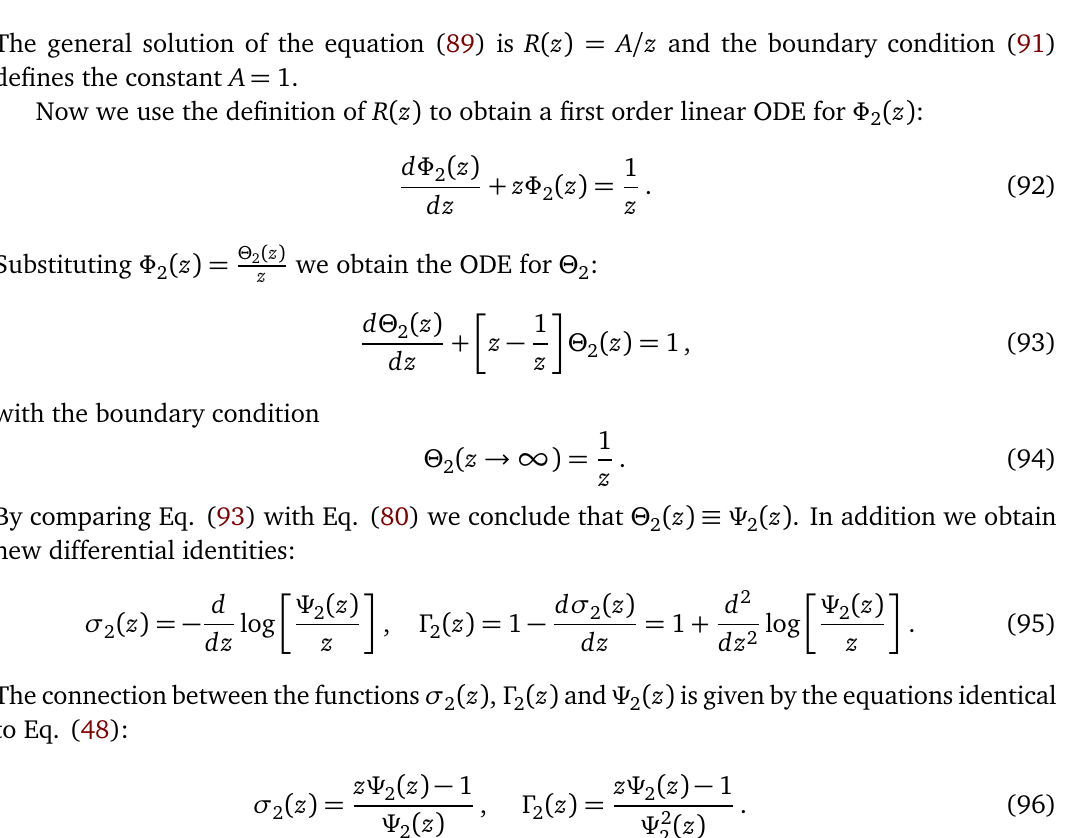
( z )] (red curve), Im [ Ψ R 2 ( z )] (blue 2